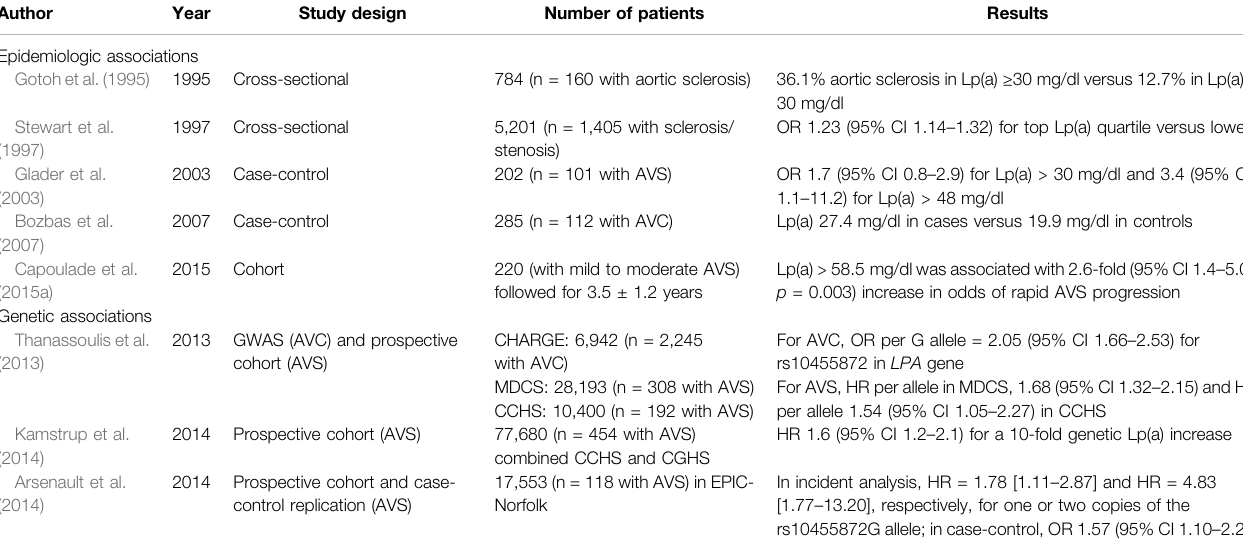
TABLE 2 | Epidemiologic and genetic associations implicating Lp(a) and LPA variants with CAVD. Author